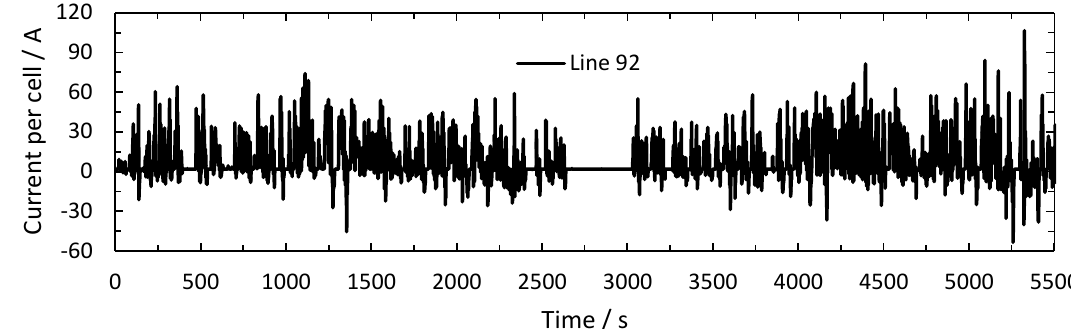
Figure 10. Current profile of the suburban line 84 in Stuttgart, Germany.